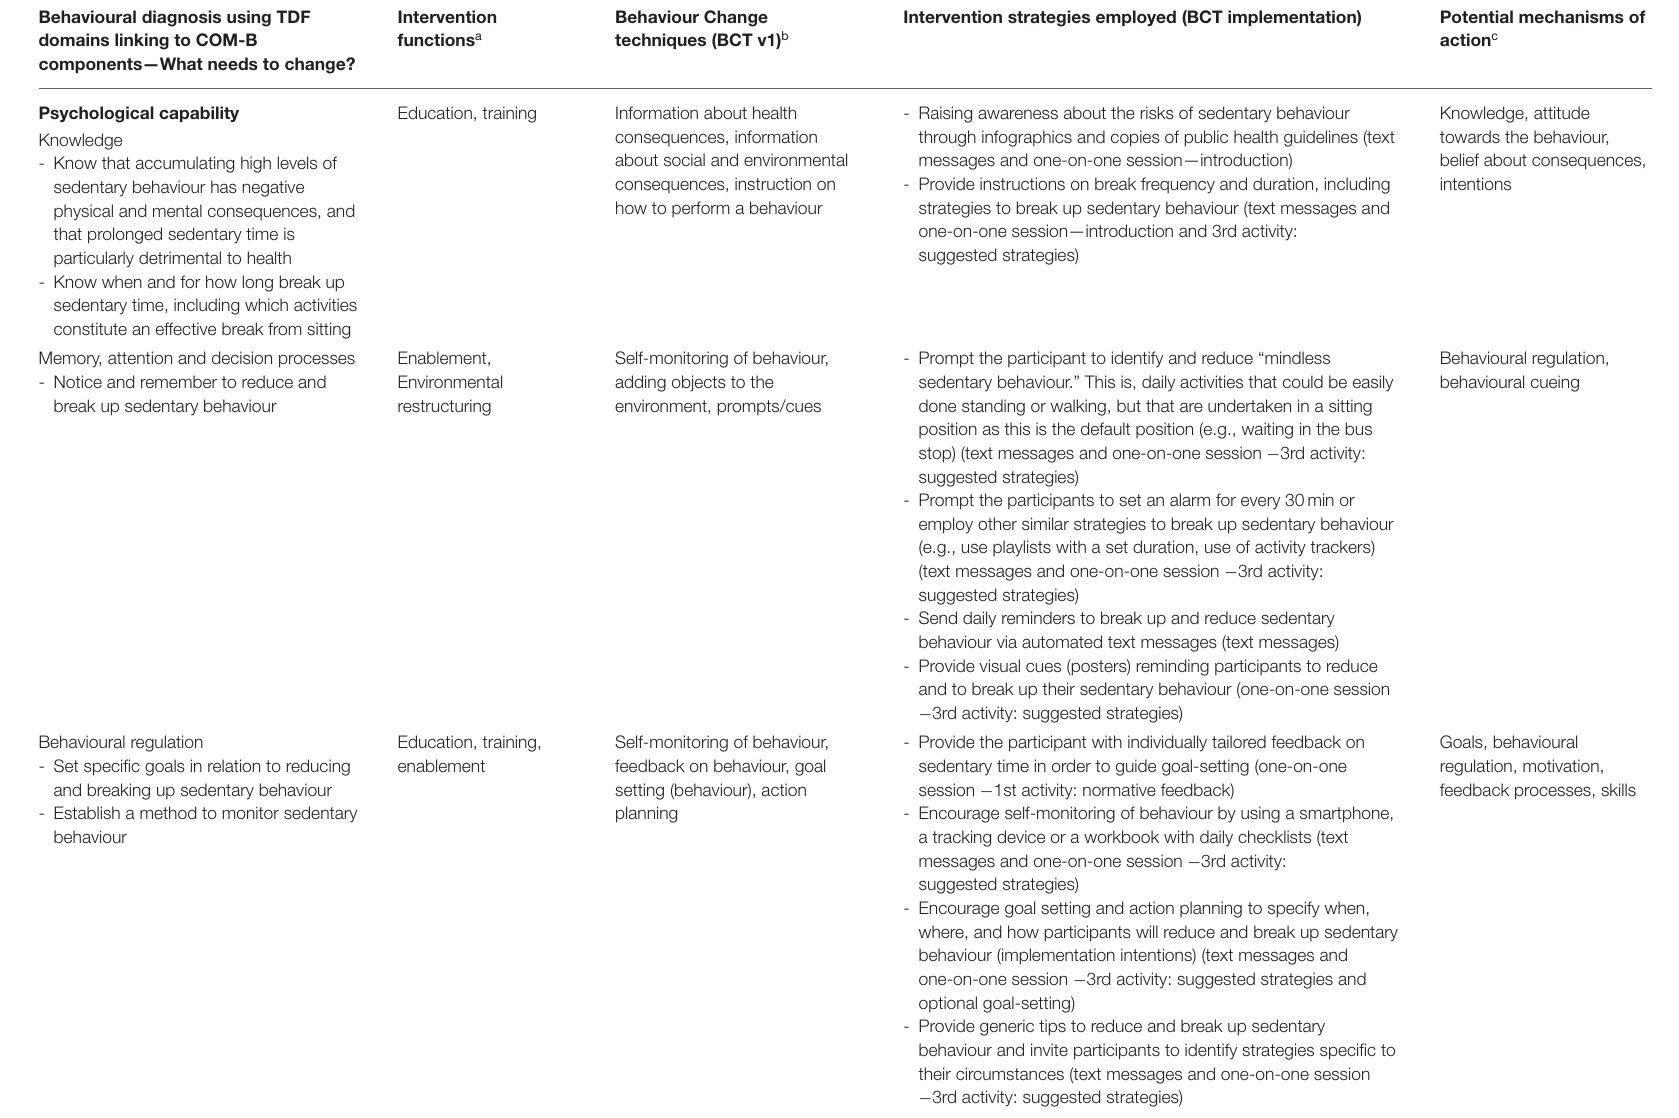
TABLE 2 | Behavioural diagnosis for target behaviour “reducing and breaking up sedentary time”, along with intervention functions, behaviour change techniques, intervention strategies, and mechanisms of action. Behavioural diagnosis using TDF domains linking to COM-B components—What needs to